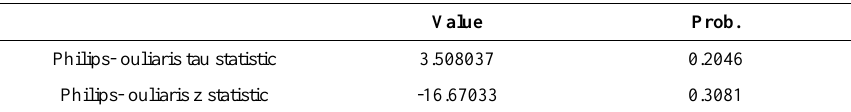
Table 4. Co- integration test- Phillips-